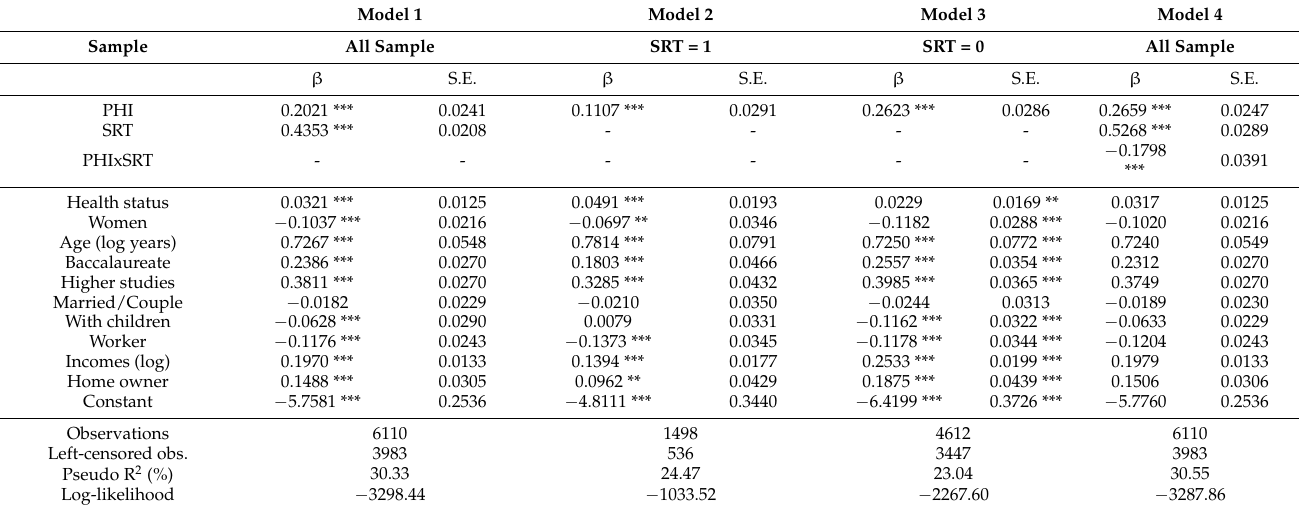
Table 4. Private health insurance and risk taking in